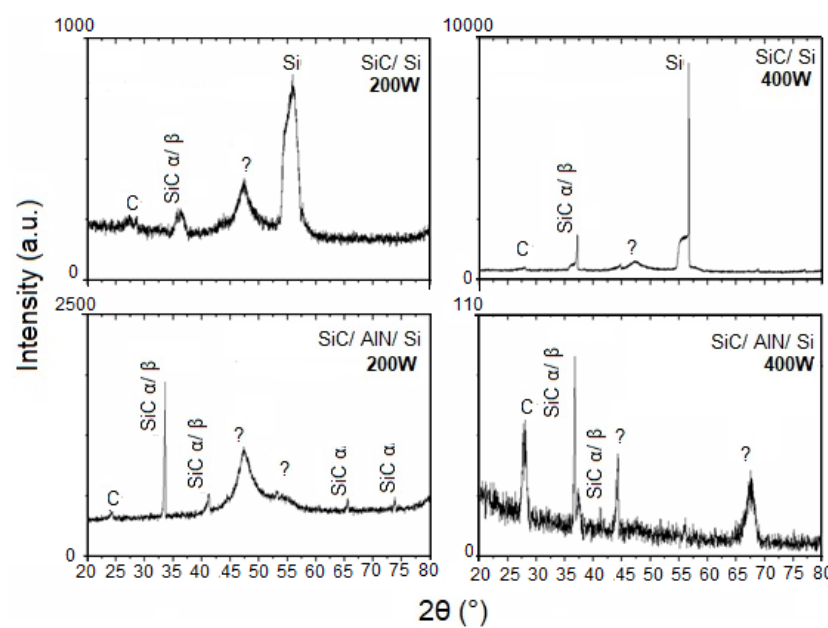
Figure 3. GIXRD patterns of the SiC thin films at a grazing angle of 1.5°.